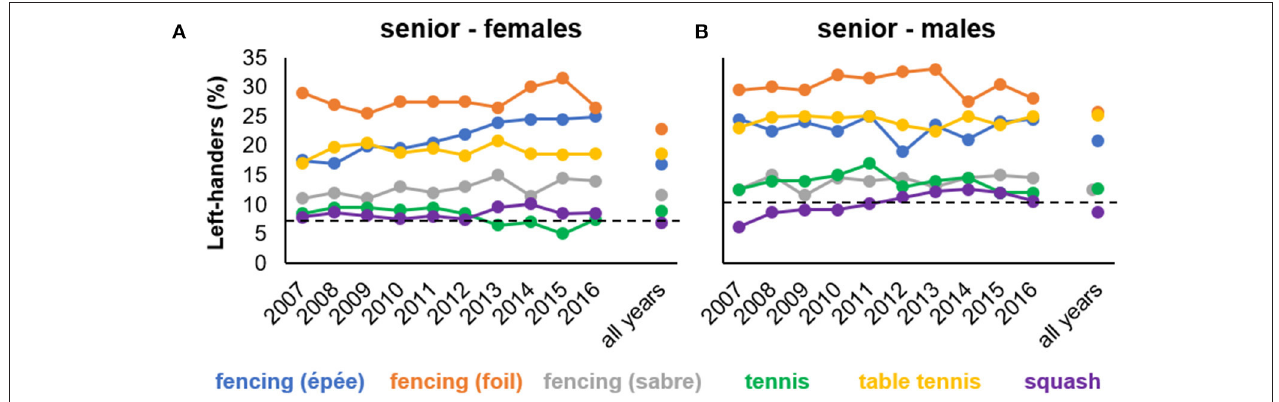
FIGURE 1 | Percentages of left-handed athletes for each year-end ranking and collapsed across all years listed for a particular sport separately for (A) female and (B) male senior competition (study 1). Horizontal dashed lines represent reference values for normal population estimates of left-handedness in females (7.7%) and males (10.3%), respectively (Raymond et al.,